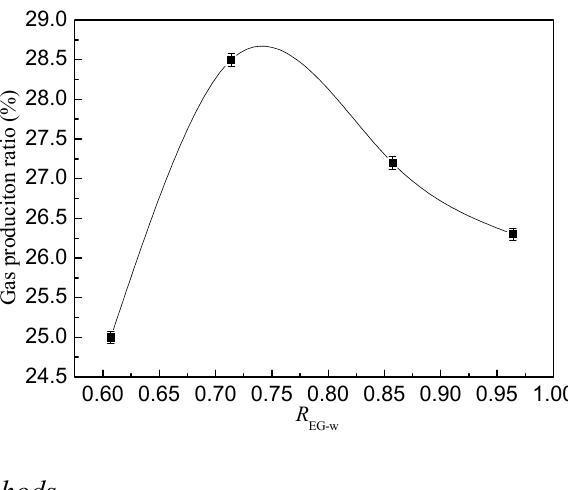
Figure 9. Variation of the gas production ratio with R glycol solution mass to the initial water mass)